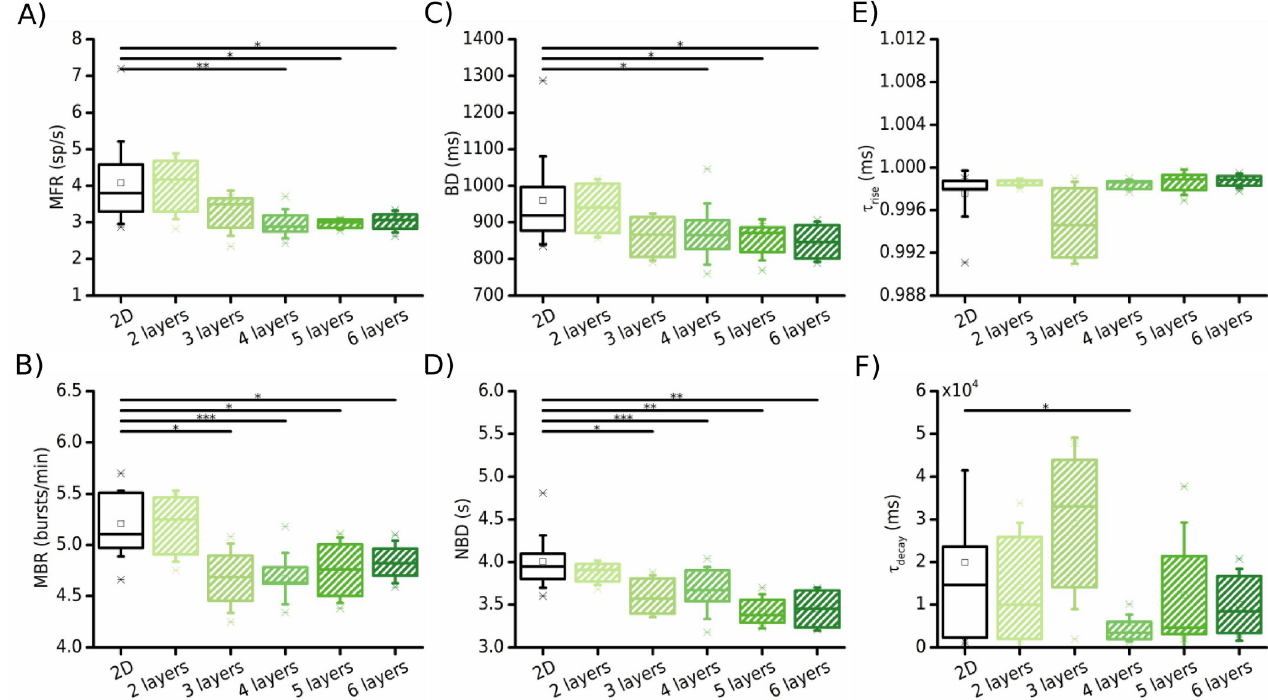
Fig 4. Effect of the number of layers (swept from 2 to 6) of the 3D model (green boxes) on the electrophysiological activity compared to the 2D networks (black boxes). ( A ) Mean firing rate, ( B ) mean bursting rate, ( C ) burst duration, ( D ) network burst duration. The temporal time constants of the rise and decay phases of the network bursts are reported in ( E ) and ( F ), respectively. ( � refers to 0.01 < p < 0.05, �� 0.001 < p < 0.01, ��� p < 0.001, Kruskal-Wallis non-parametric test).